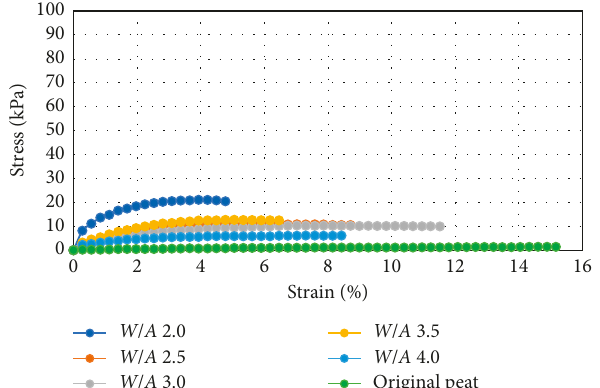
Figure 3: Stress vs. strain of peat B specimens after 28 days air-